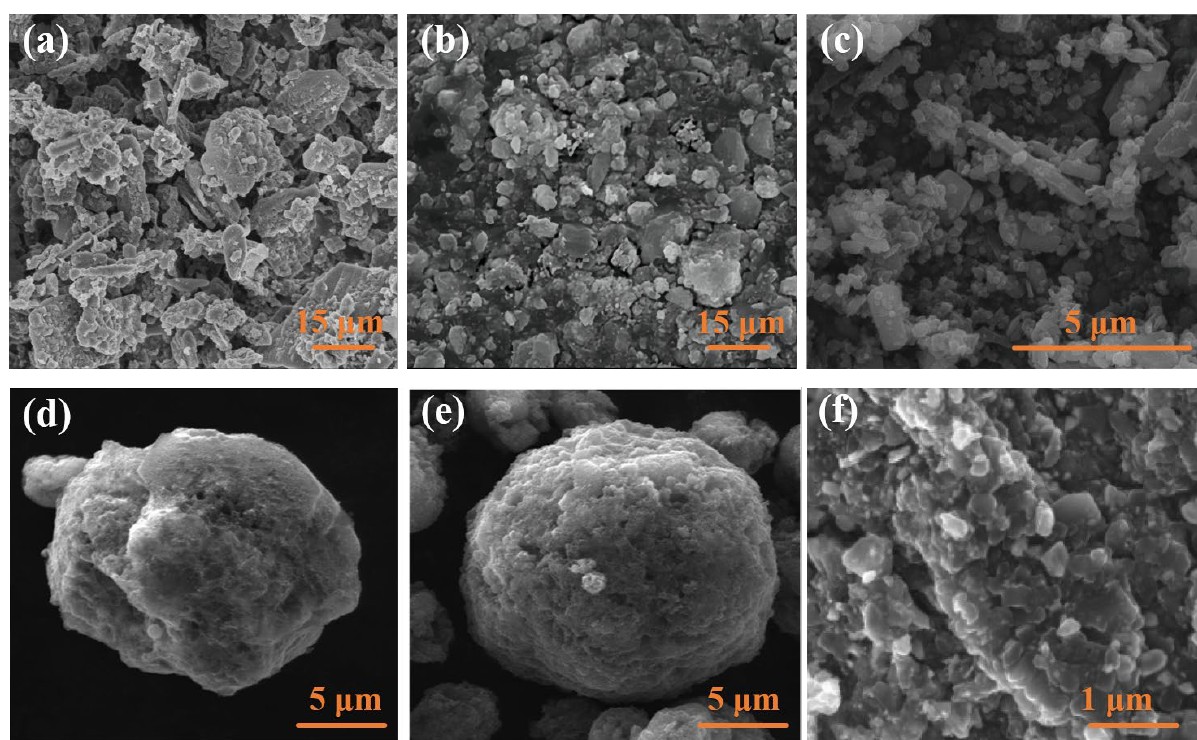
Figure 15. SEM images of ( a ) raw boron [110]; ( b ) B@NiO [111]; ( c ) B@CuO [112]; ( d ) B@SnO 2 [113]; ( e ) B@TiO 2 [113]; and ( f ) B@CeO 2 [114]. Boron Coated with TiO 2 or SnO